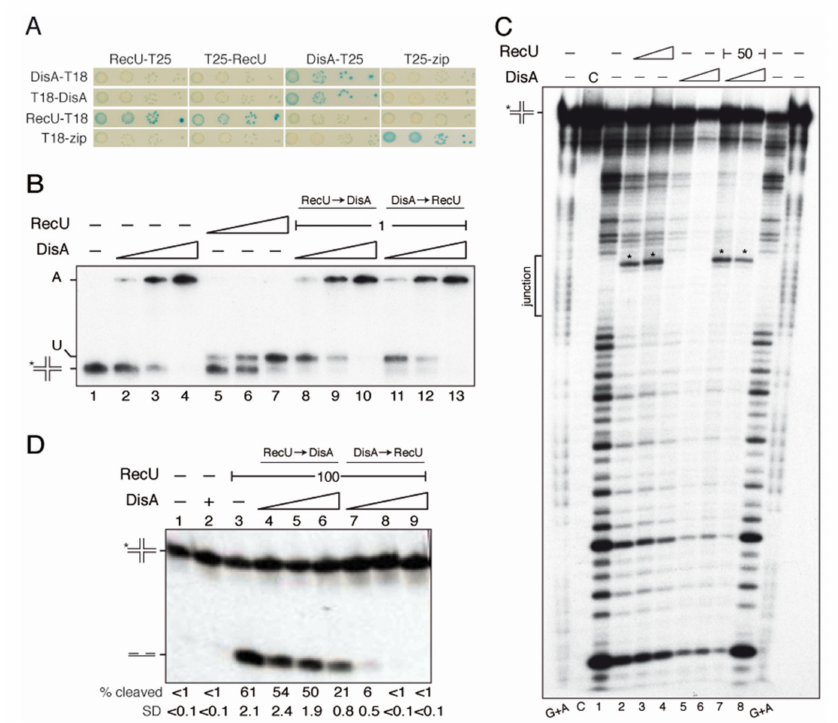
Figure 5. DisA does not interact with RecU but inhibits RecU-mediated HJ cleavage. ( A ) DisA interaction with RecU was not observed by the bacterial two-hybrid interaction assay. ( B ) [ γ - 32 P] HJ DNA was pre-incubated with increasing DisA concentrations (doubling from 12–48 nM) or RecU (doubling from 0.25–1 nM) for 15 min in buffer C containing 1 mM MgCl 2 (5 min at 37 ◦ C).